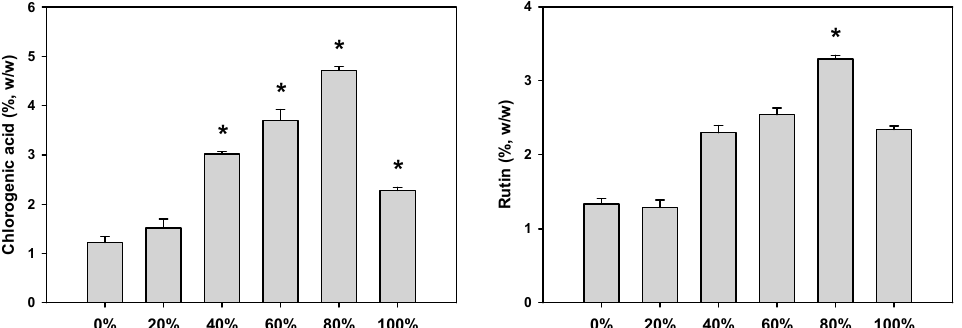
Figure 3. Contents of chlorogenic acid and rutin in hot water (0%) and ethanolic extracts (20–100%) of D. morbifera leaf. Ethanolic extracts were prepared with 20–100% ethanol. The asterisk represents a value significantly different from the other groups ( p < 0.05). Values were the mean ± standard deviation ( n = 3).